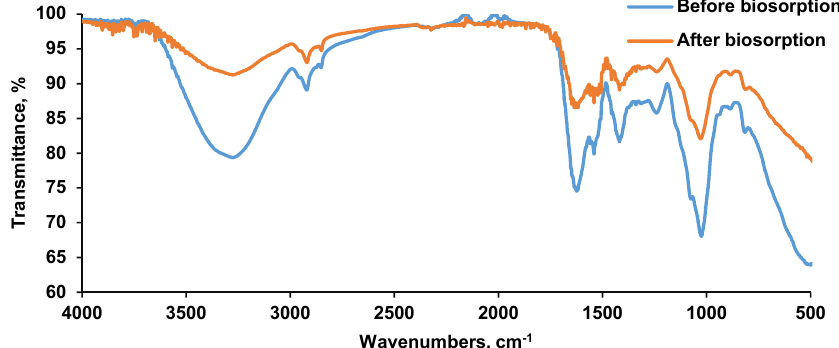
Figure 5. FT-IR spectra of the biosorbent before and after biosorption.